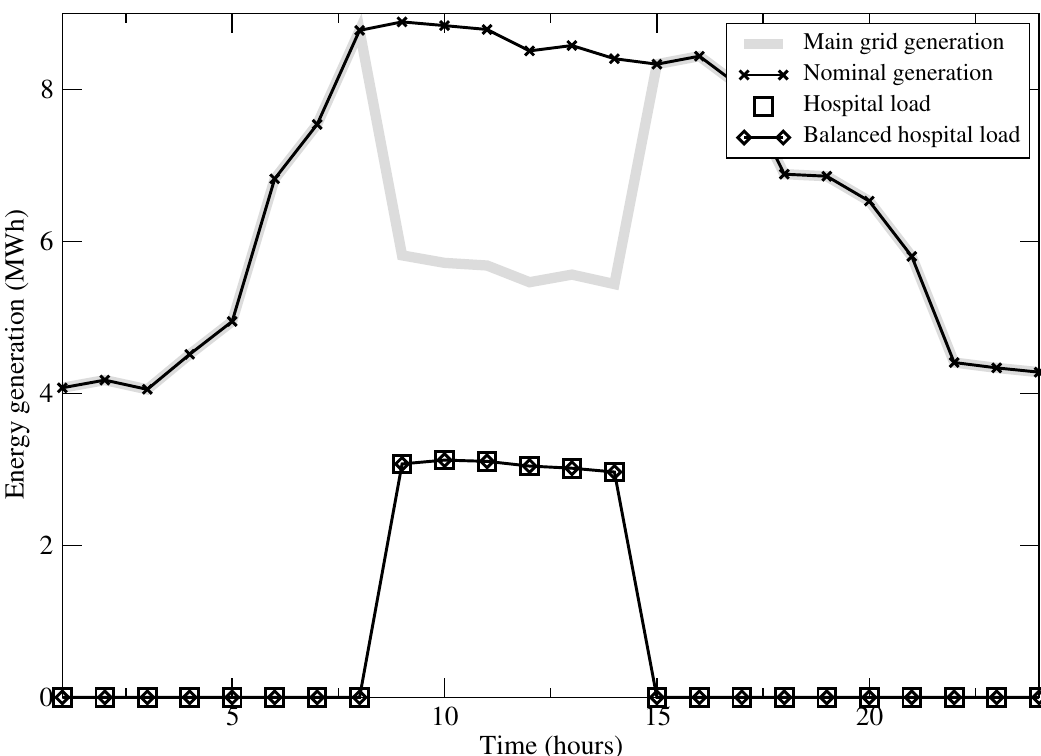
Figure 4. The resultant energy generation distribution, the nominal generation and the generation distribution of hospital load during an